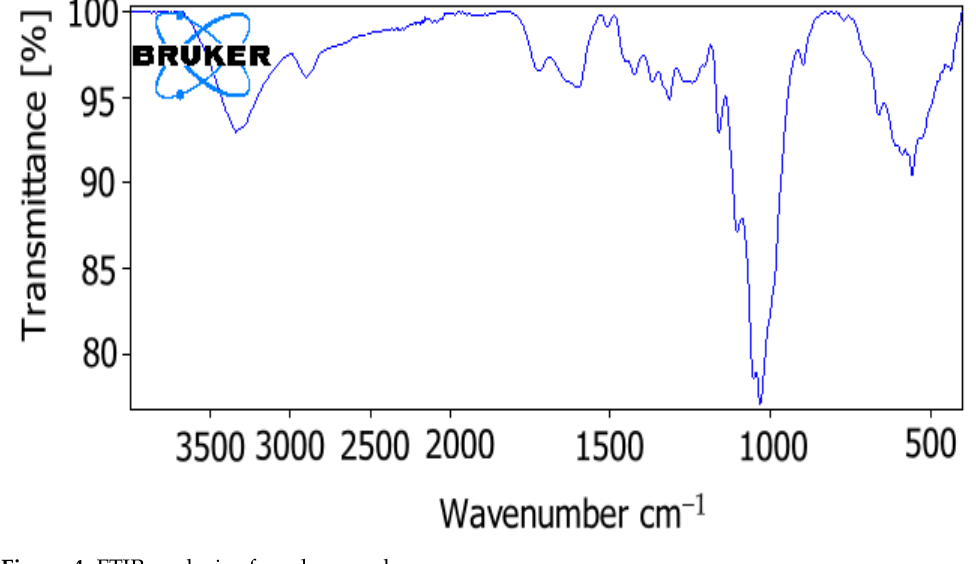
Figure 4. FTIR analysis of poplar wood.